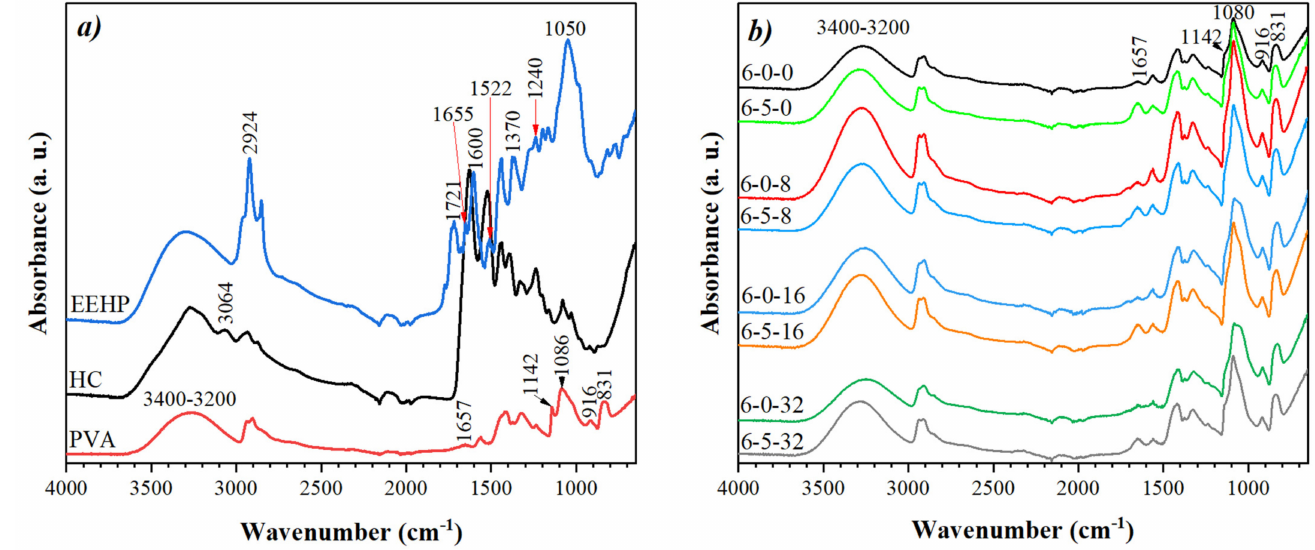
Figure 5. FTIR spectrum of ( a ) raw materials and ( b ) membranes obtained by electrospinning with EEHP at different concentrations (0, 8, 16, 32) and with and without hydrolyzed collagen